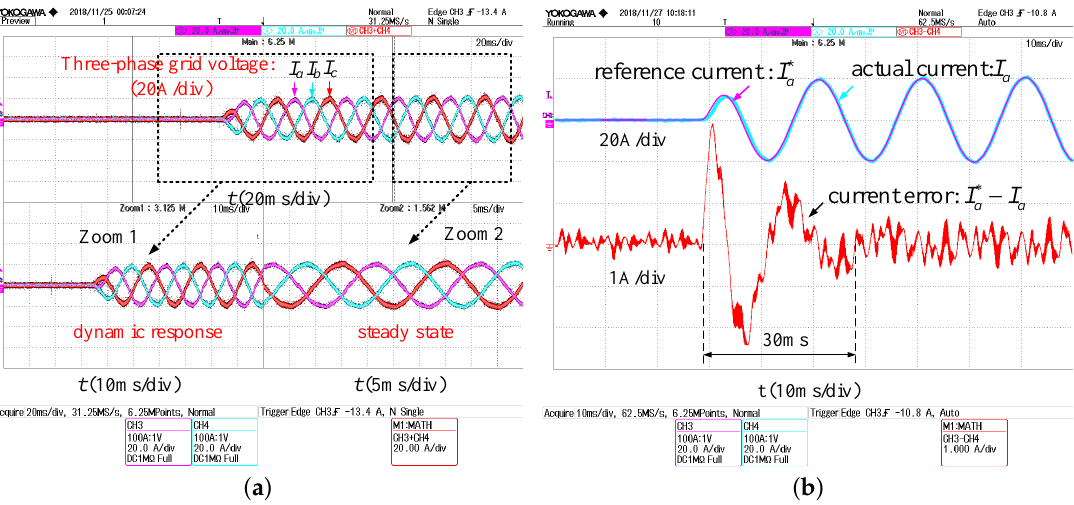
Figure 17. Experimental results of the PCI-based control strategy: ( a ) three-phase grid current when 10 kvar reactive power is applied; and ( b ) reference current, actual current and current error of phase A when load